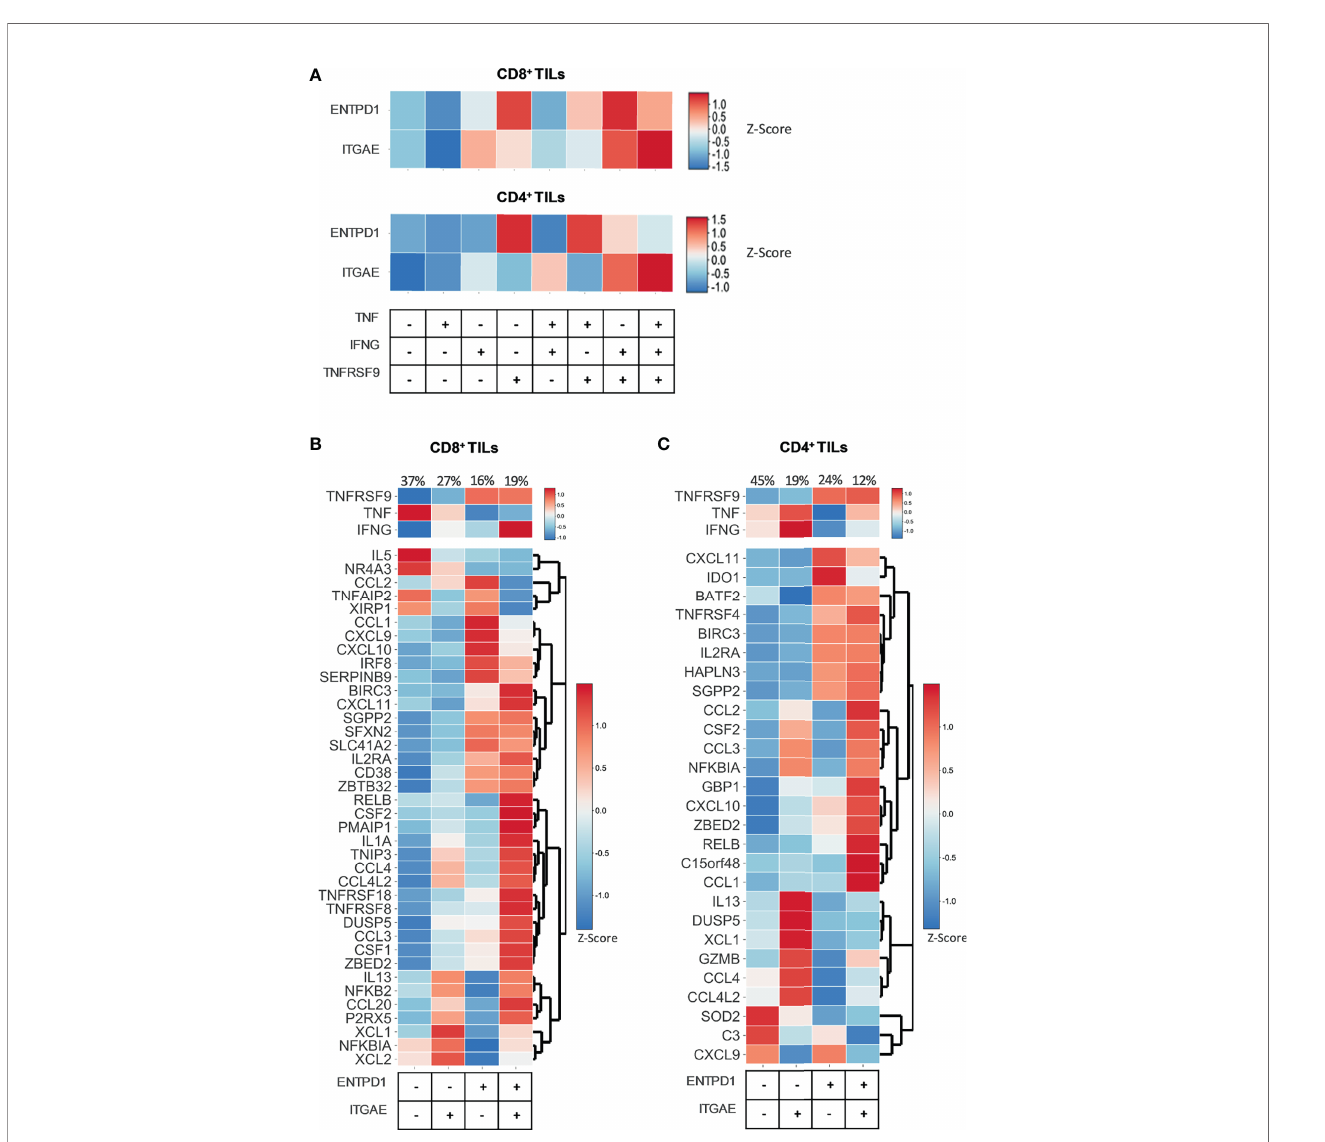
FIGURE 4 | ENTPD1 and ITGAE do not fully discriminate the tumor-speci fi c reactive TIL population in situ . Heatmaps showing data from 12748 single CD8 + TILs and 10654 single CD4 + TILs isolated from tumor tissue of four different cancer types (non-small-cell lung cancer, hepatocellular carcinoma, colorectal cancer, and melanoma). Six selected scRNAseq datasets from public repositories were re-analyzed to produce this fi gure (see Supplementary Table 2 ). (A) The heatmaps show the expression (Z-score) of the genes ENTPD1 and ITGAE within eight functional clusters of CD8 + and CD4 + TILs identi fi ed in situ through the differential expression of TNFRSF9, TNF , and IFNG . Every functional cluster represents a different combination of TNFRSF9, TNF , and IFNG expression. The expression of ENTPD1 and ITGAE was heterogeneous across the different clusters, with ENTPD1 expression being primarily associated with TNFRSF9 expression. (B, C) The heatmaps show the expression (Z-score) of TNFRSF9, TNF , and IFNG and of the genes belonging to the (B) CD8 and (C) CD4 tumor-speci fi c activation gene sets within four clusters of CD8 + and CD4 + TILs identi fi ed in situ through the differential expression of ENTPD1 and ITGAE . Each cluster represents a different combination of ENTPD1 and ITGAE expression. Despite most genes being highly expressed in ENTPD1 + and/or ITGAE + positive clusters, the expression of some genes included in the activation gene sets was observed within the ENTPD1 - ITGAE - cluster. CD39 and CD103 are useful, but not suf fi cient to discriminate the entire repertoire of tumor-speci fi c reactive TILs in situ